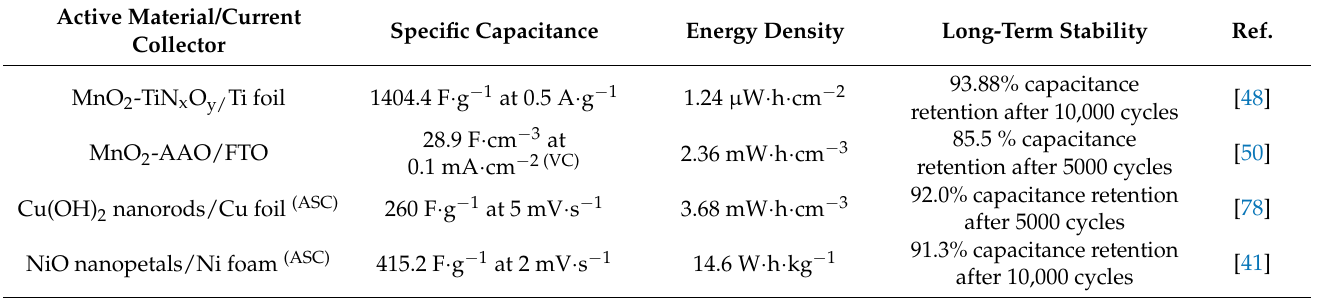
Table 5. Pseudocapacitive materials based on anodized oxides tested in symmetrical and asymmetrical supercapacitors in aqueous